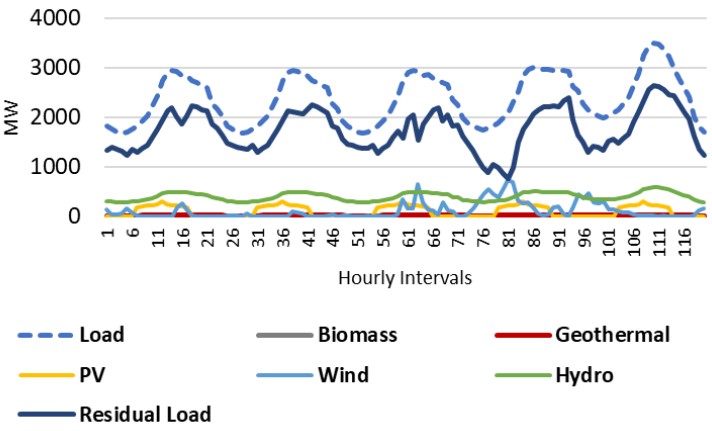
Figure 10. Residual load and renewable energy contribution during the examined period. The actual values of the considered energy system pertaining to the worst day are tabulated in Table 3, along with the dynamic, spinning reserve requirement. Table 3. MW-output of different renewable systems across the residual load.